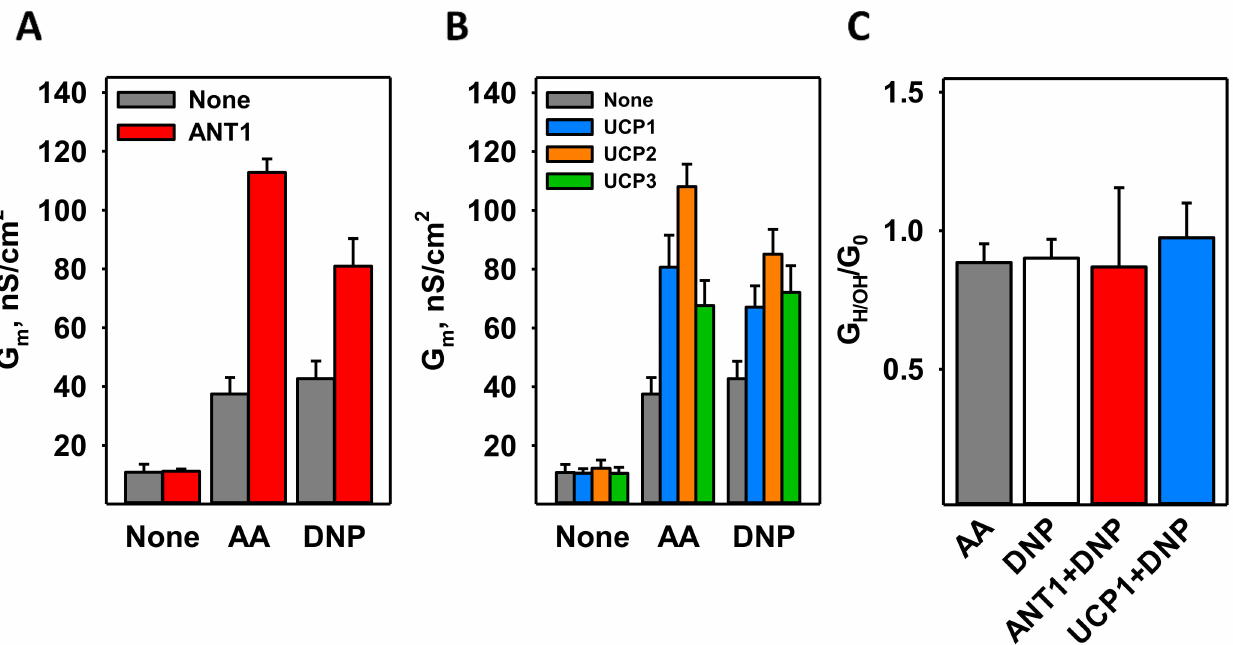
Figure 2. DNP-mediated proton transport in the presence of mitochondrial membrane proteins reconstituted in planar lipid bilayers. ( A ) Increase in the total specific membrane conductance (G m ) in the presence of arachidonic acid (AA) or DNP without (gray) and with ANT1 (red). ( B ) Increase in G m in the presence of AA or DNP without protein (gray) or with UCP1 (blue), UCP2 (orange), or UCP3 (green). ( C ) The ratio of proton conductance to total membrane conductance (G H/OH /G 0 ) was measured at a transmembrane pH gradient of 0.4. The concentrations of AA and DNP were 15 mol% and 50 µ M. For all measurements, the membranes were made of DOPC:DOPE:CL (45:45:10 mol%). Lipid and protein concentrations were 1.5 mg/mL and 4 µ g per mg of lipid. The buffer solution consisted of 50 mM Na 2 SO 4 , 10 mM Tris, 10 mM MES, and 0.6 mM EGTA at pH = 7.34 and T = 32 ◦ C. Data are the mean ± SD of at least three independent